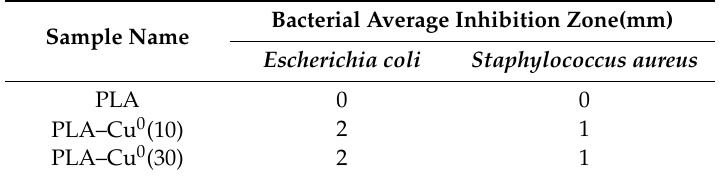
Table 9. Results of tests on the antibacterial activity of polylactide nonwoven (PLA) and polylactide-copper composites (PLA–Cu 0 (10) and PLA–Cu 0 (30)) on the basis of standards EN-ISO 20645:2006